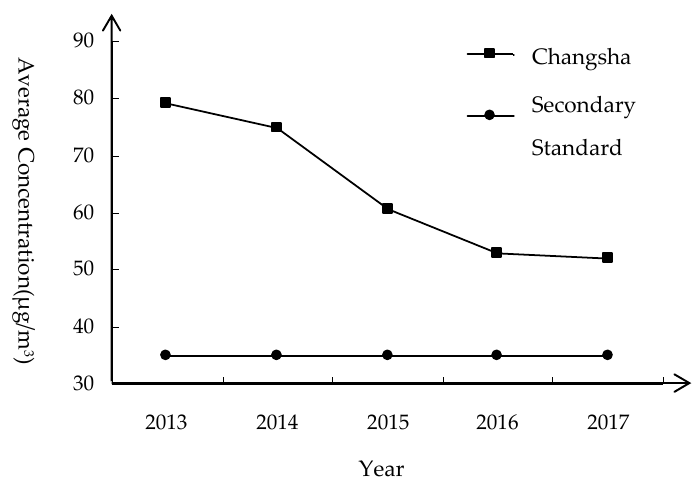
Figure 5. Comparison of PM 2.5 annual average concentration and secondary standard in Changsha 2013 to 2017.